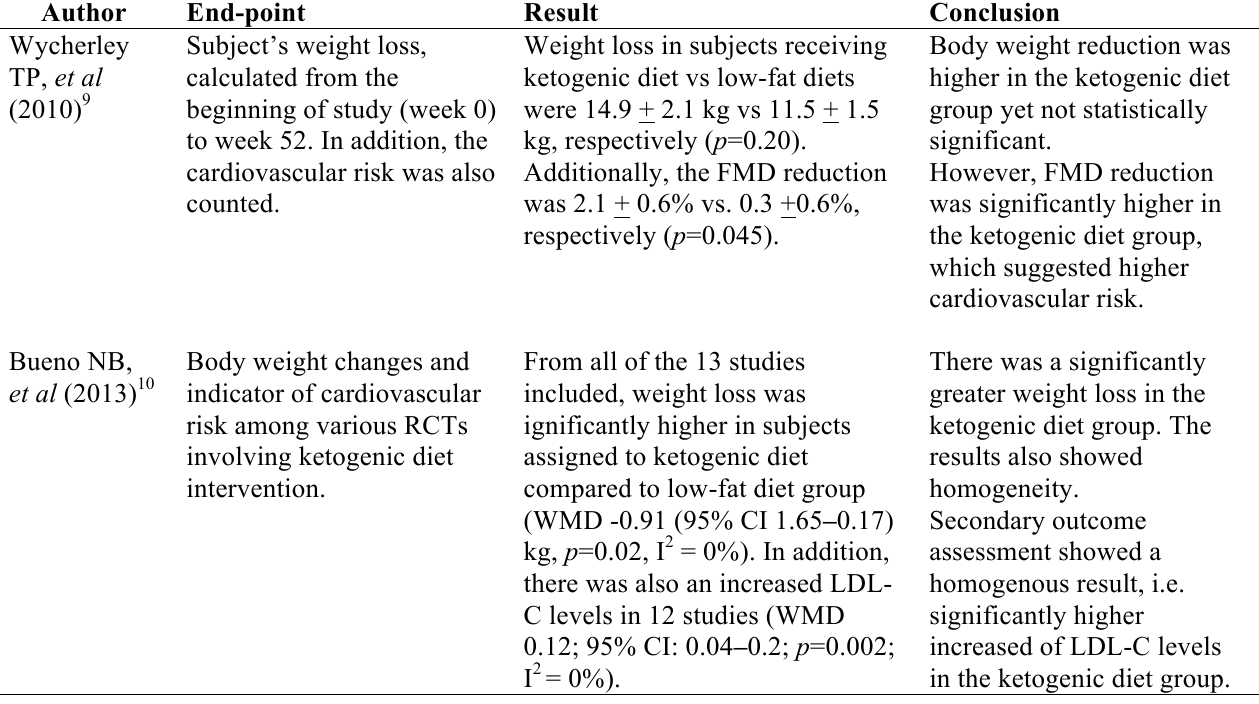
Table 7. Summary of results from both studies